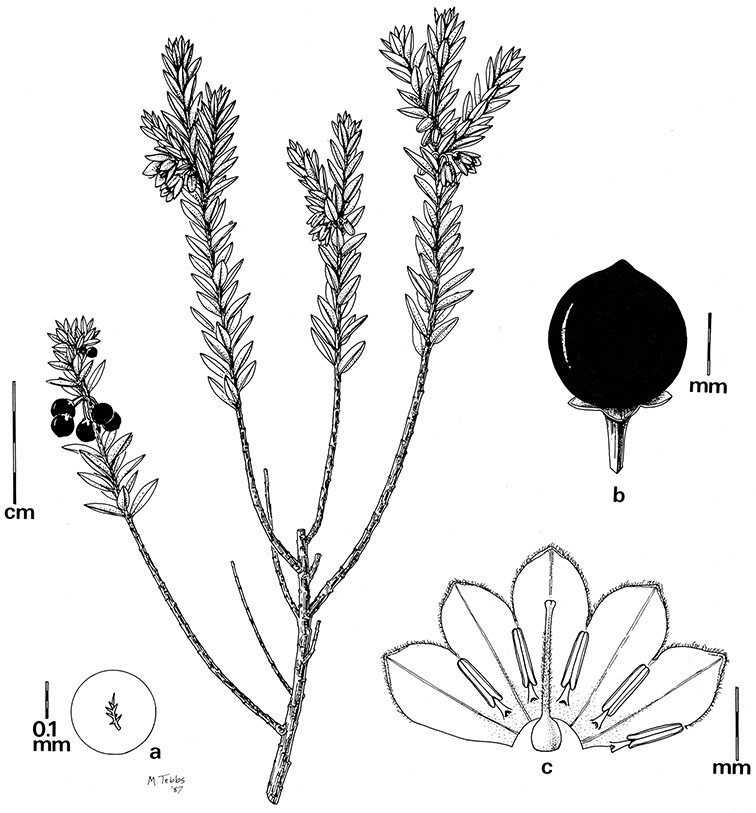
Solanum macbridei Hunz. & Lallana. (A–C drawn from Solomon & Stein 11660). Reproduced from Knapp (1989) with permission of the Natural History Museum Botany Library. Illustration by Margaret Tebbs.